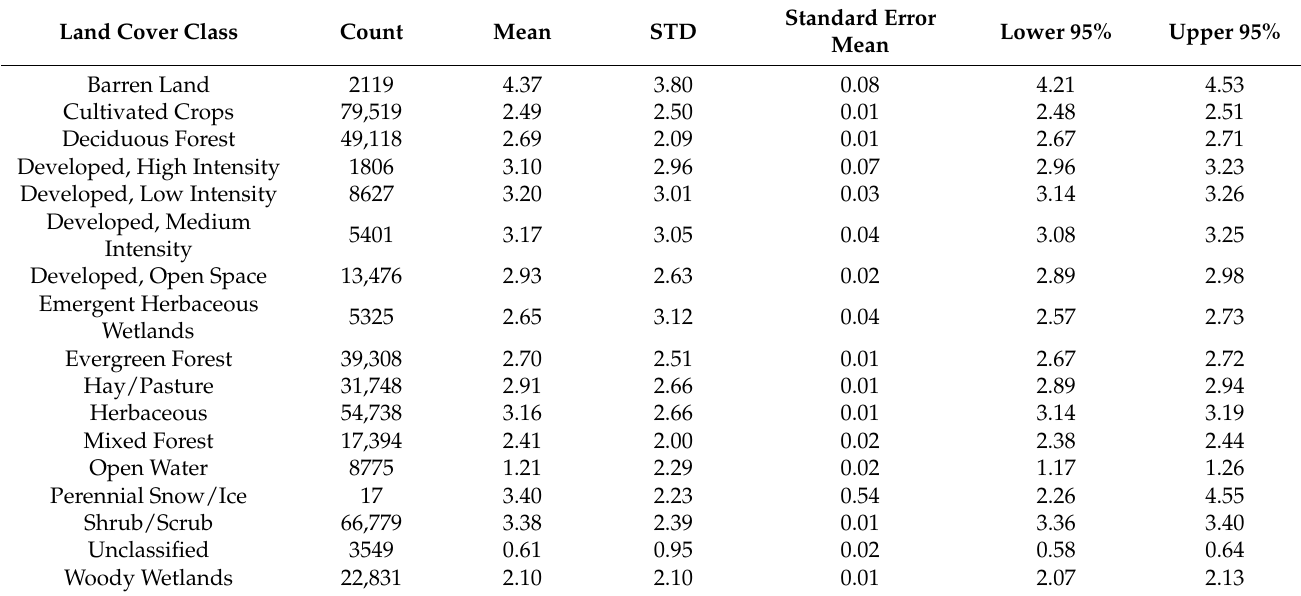
Table 7. Ground point density (points per square meter) by landcover class. STD = Standard Deviation.